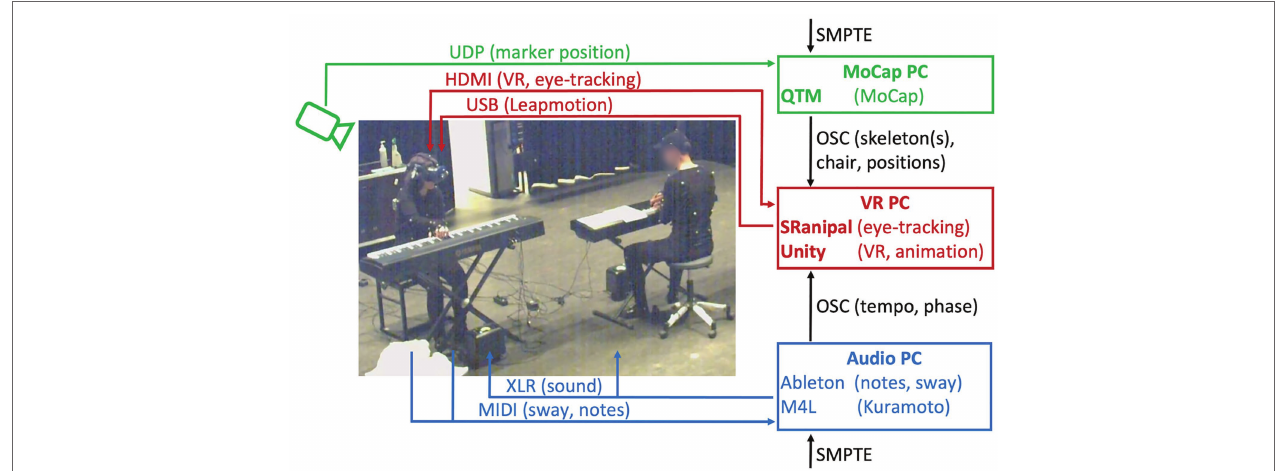
FIGURE 4 | Schematic overview of the case-study’s technical